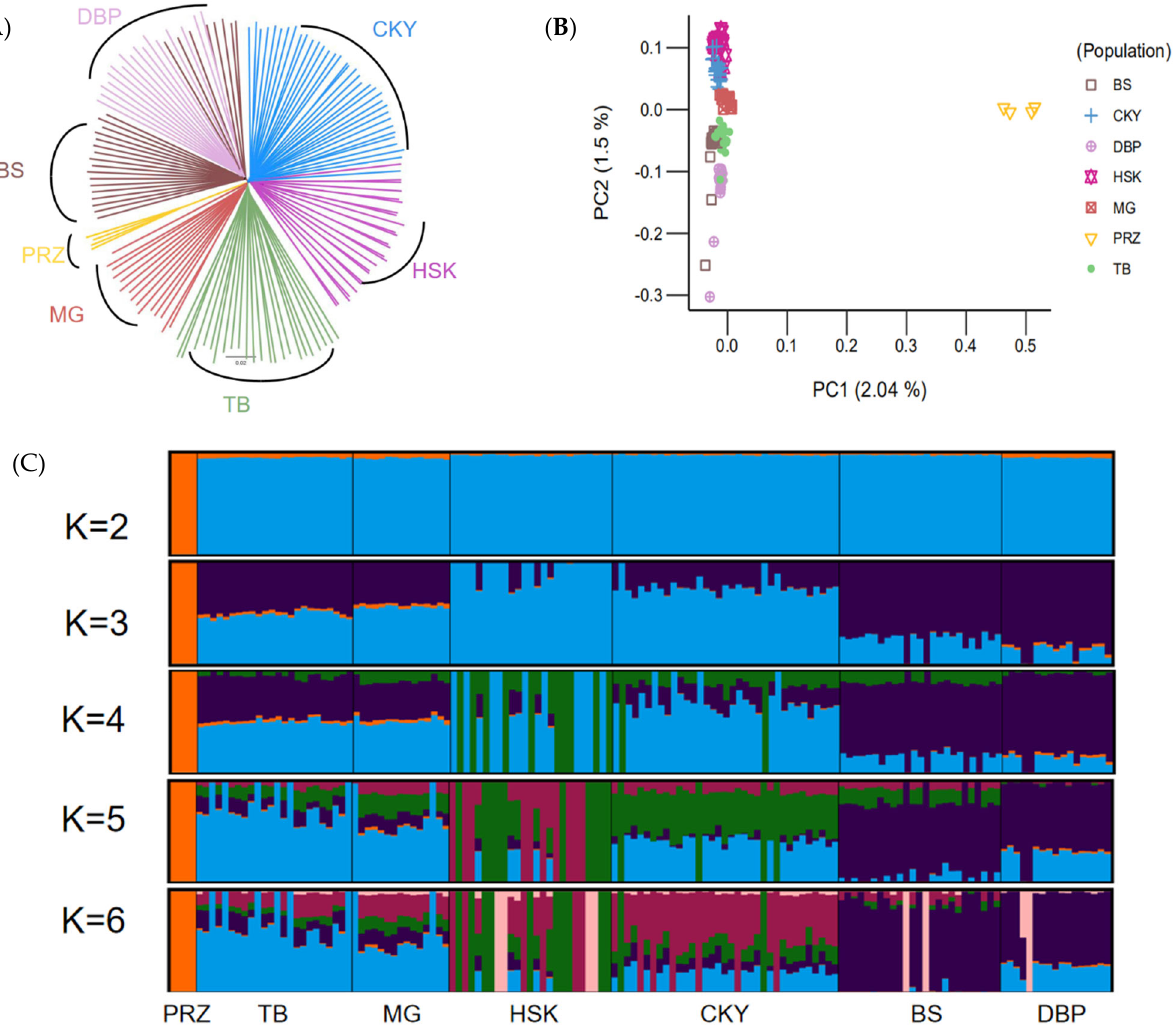
Figure 2. Population genetic relationship between Chakouyi horses and the other Chinese horse breeds. ( A ) Relationships among the six studied CHBs illustrated by a neighbor-joining tree. The populations studied are indicated with different colors and the names of the breeds. ( B ) PCA plot of the CHBs. The studied populations are indicated with different colors. ( C ) ADMIXTURE analysis of the Chakouyi horse and other CHBs. Each column indicates an individual, and each column group represents a horse population. CKY, Chakouyi horse; HSK, Kazak horse; MG, Mongolian horse; TB, Tibetan horse; BS, Baise horse; DBP, Debao pony; PRZ, Przewalski’s horse. The linkage disequilibrium (LD) coefficient of each CHB was calculated (Figure 3A). The Chakouyi horses showed the fastest LD decay rate and the smallest LD decay distance, while the Mongolian horses, Debao ponies, and Tibetan horses had a relatively slow LD decay rate and large LD decay distances. However, the genetic diversity revealed with the heterozygosity in the Chakouyi horses at a genomic level was relatively low (Table S2). Four migration events among the studied CHBs were detected with the TreeMix program as m = 4 (Figure 3B,C). The admixture proportions of the migration events from the Tibetan horses to the Chakouyi horses, and the Chakouyi horses to the Baise horses were relatively and from Mongolian horses to Debao ponies were also detected, but they showed relatively low admixture proportions. The migration model mainly showed the gene flows